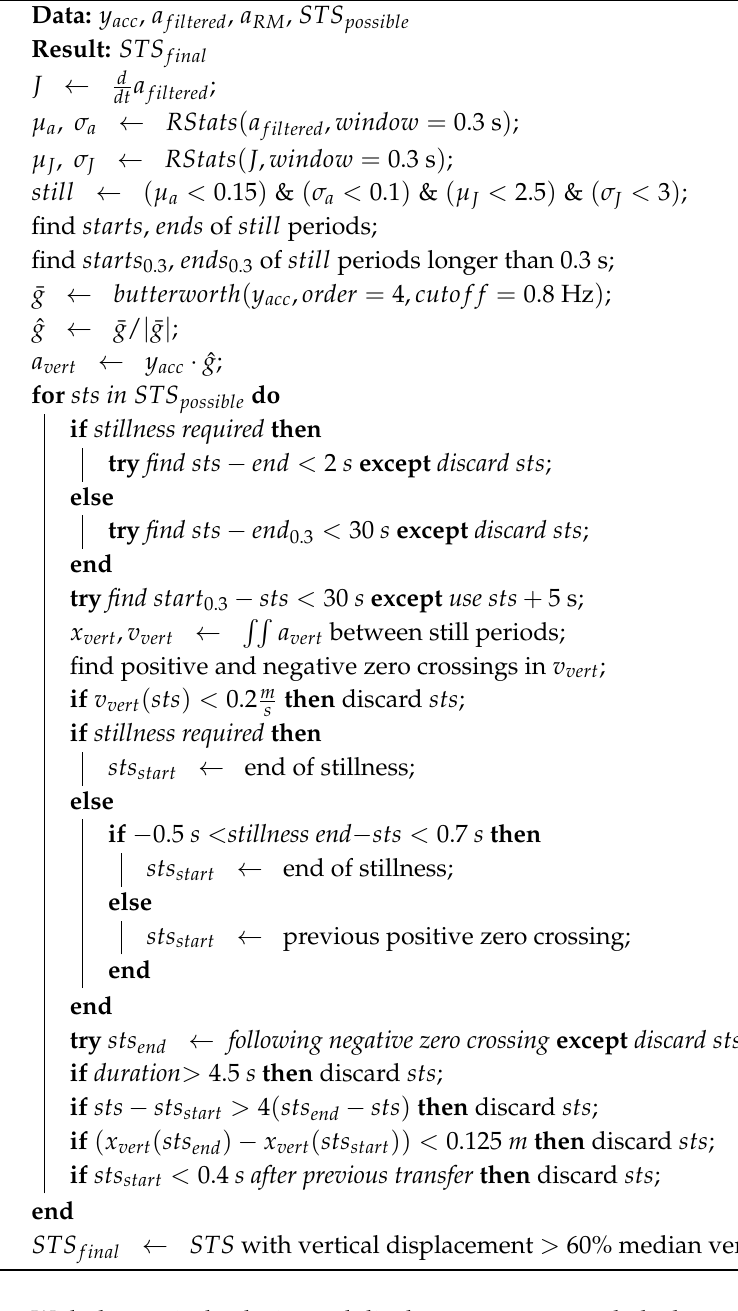
Algorithm 2: Algorithm for validating sit-to-stand (STS) transfers given the filtered acceleration and the possible STS locations from the first processing step. RStats is the computation of the rolling mean and standard